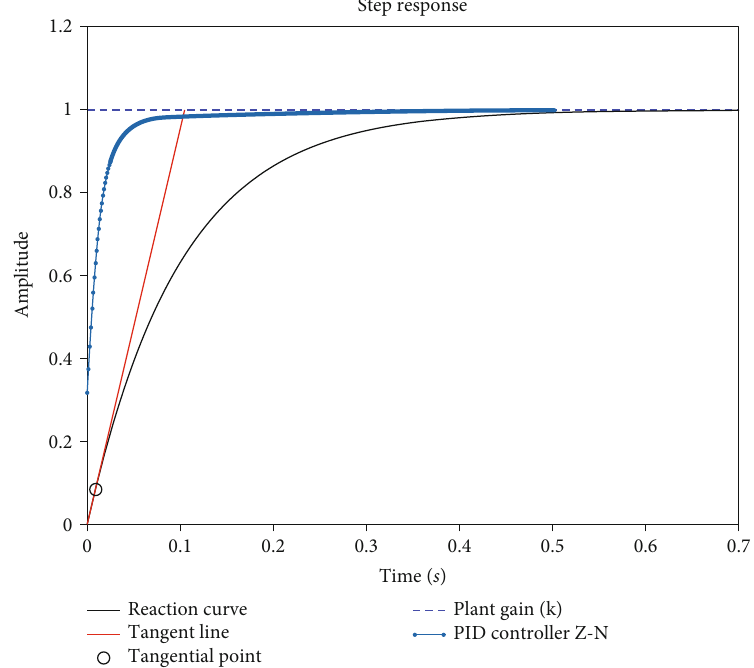
Figure 13: Reaction curve or a